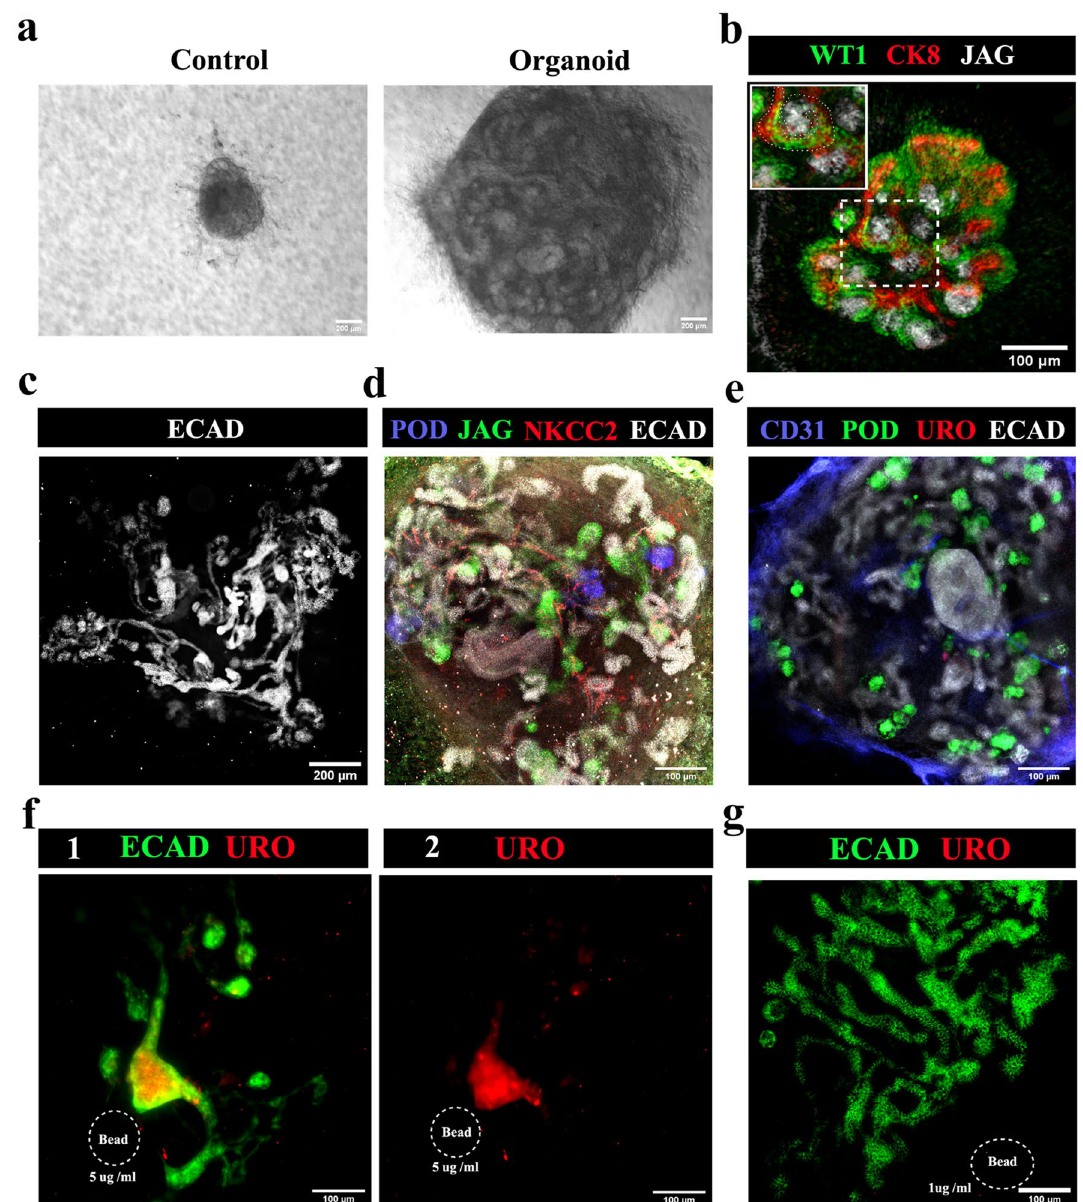
Figure 6. All-mESC organoids form nephrons connected to a ureteric bud/ collecting duct tree. ( a ) Bright field images of all-mESC-derived organoids, the control being an aggregate of iNP and iSP cells with no eUB: the iNP + iSP + eUB organoids grew ( n = 15/18) while the controls did not ( n = 0/3). Scale bar, 200 µm. ( b ) Early nephrogenesis around eUB branch tips at day 3 [an S shaped body is marked by a dotted line in the inset image] ( n = 4/4), which grew and formed ( c ) a single connected ureteric bud-nephron tree structure by day 7 ( n = 4/4). Scale bar: ( b ) 100 µm, ( c ) 200 µm. ( d ) Full-length nephron formation with podocytes, proximal tubules and distal tubules (n = 4/4); and ( e ) no uroplakin-positive ureter formation ( n = 0/6) at day 10. Scale bar, 100 µm. ( f ) Uroplakin-positive ureter-like structure formation in the organoids induced by BMP4-soaked beads (5 µg /ml). Collecting duct-nephron tree is stained for ECAD. (1) Merged and (2) uroplakin channel images are shown. n = 2/6. Scale bar, 100 µm. ( g ) The lower concentration of BMP4 (1 µg/ml) did not induce uroplakin-positive structures ( n = 4/4). Abbreviations: POD: podocalyxin (podocyte marker), JAG: jagged1 (proximal tubule marker), NKCC2: Na–K–Cl cotransporter 2 (distal tubular marker), ECAD: E cadherin (ureteric bud/distal tubular marker), CD31: platelet endothelial cell adhesion molecule (endothelial cells marker), URO: uroplakin (ureter marker), CK8: cytokeratin 8 (ureteric bud marker), WT1: Wilms Tumour 1 (podocyte/cap mesenchyme